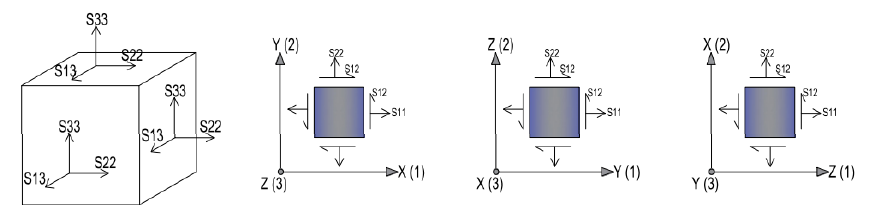
Figure 5. Sign alignment and direction assumptions.